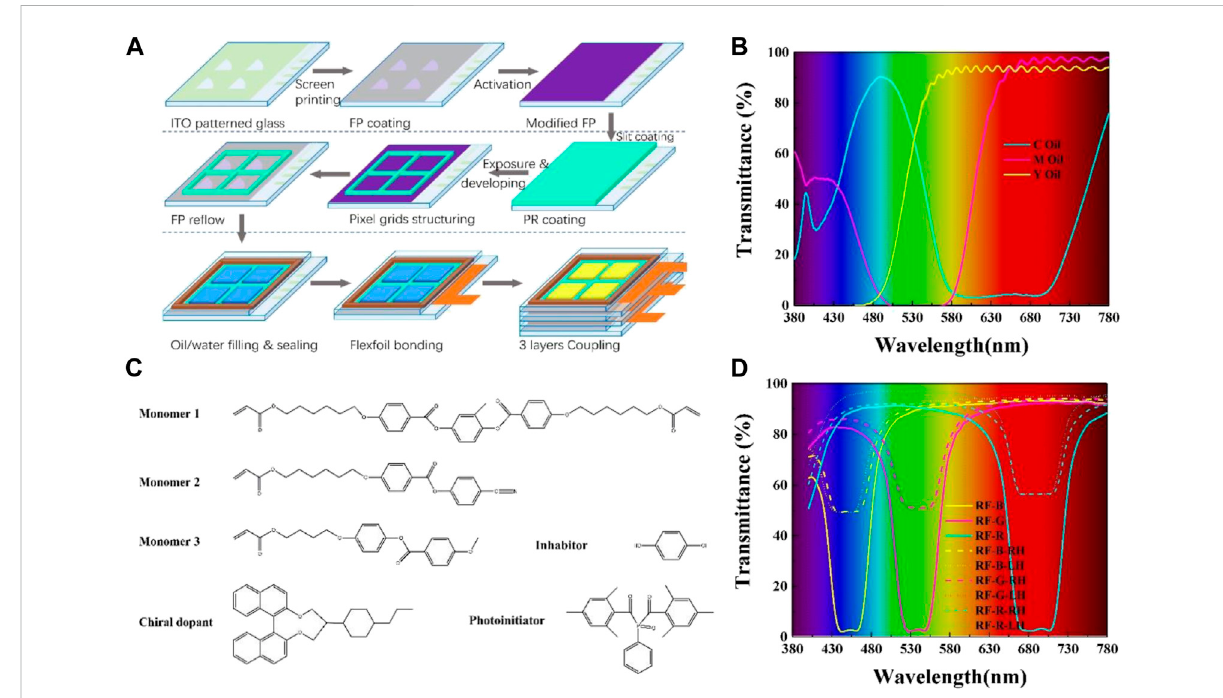
FIGURE 2 Fabricationoftri-layerEWDdeviceandPCLC fi lm: (A) fabricationprocessoftri-layerEWDdevice, (B) transmittancespectrumofCMYoil, (C) LC monomer materials for PCLC fi lms and (D) transmittance spectrum of PCLC fi